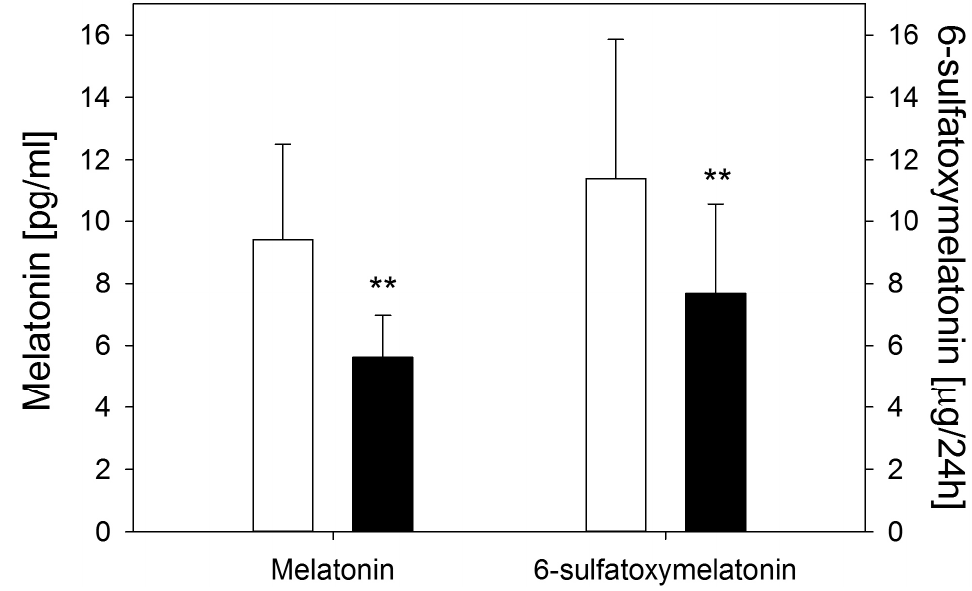
Figure 3. Fasting serum melatonin levels and urinary excretion of 6-hydroxymelatonin sulfate (6-HMS) (µg/24 h) in control subjects (white bars) and patients with continuous epigastric pain syndrome (black bars). n = 30 in either group; error bars denote standard deviation; ** p < 0.01 compared with